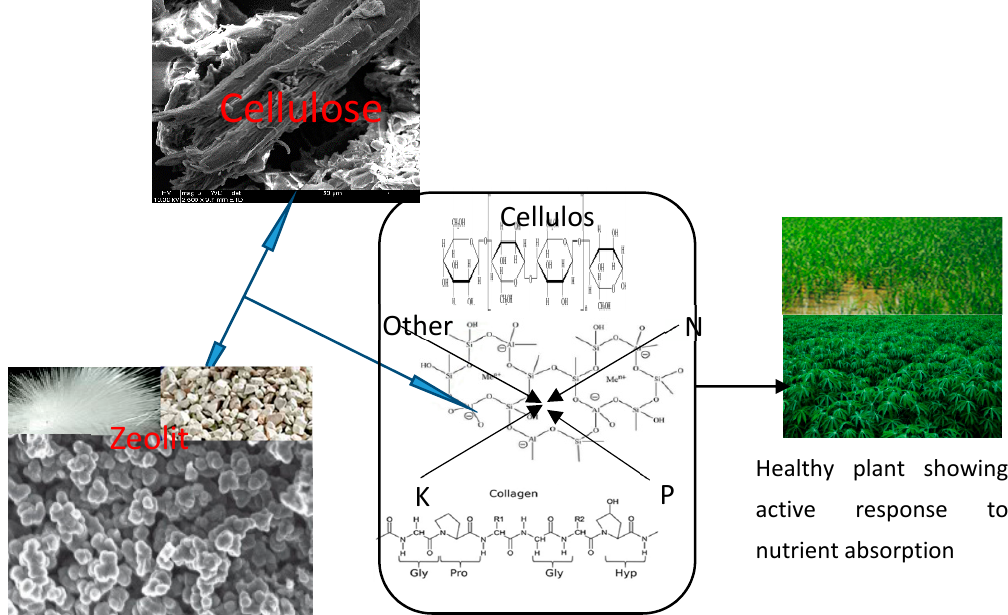
Figure 1. Negatively charged zeolite platform enhanced by natural polymers and other nutrients for optimum crop performance. Adapted from